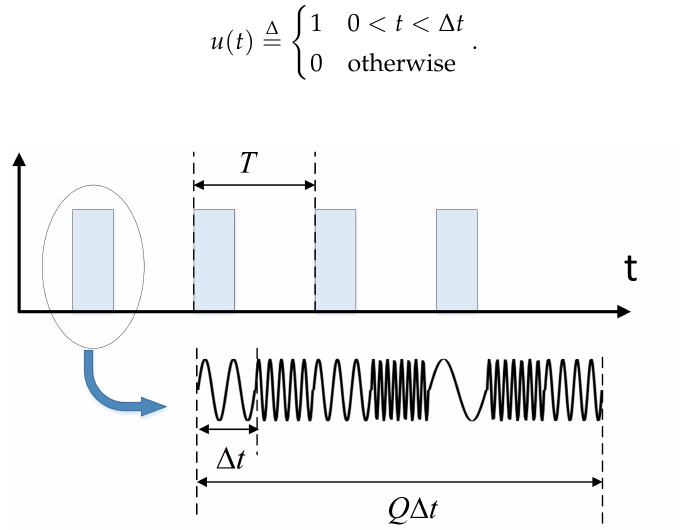
Figure 3. Waveform of the inner-and-inter pulse frequency hopping